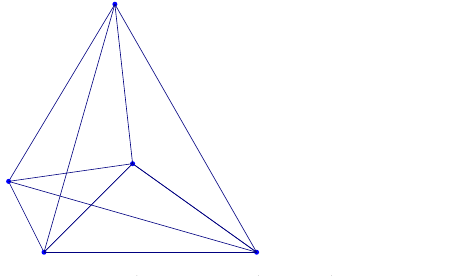
Figure 2. Multi-connected irregular geometrical grid